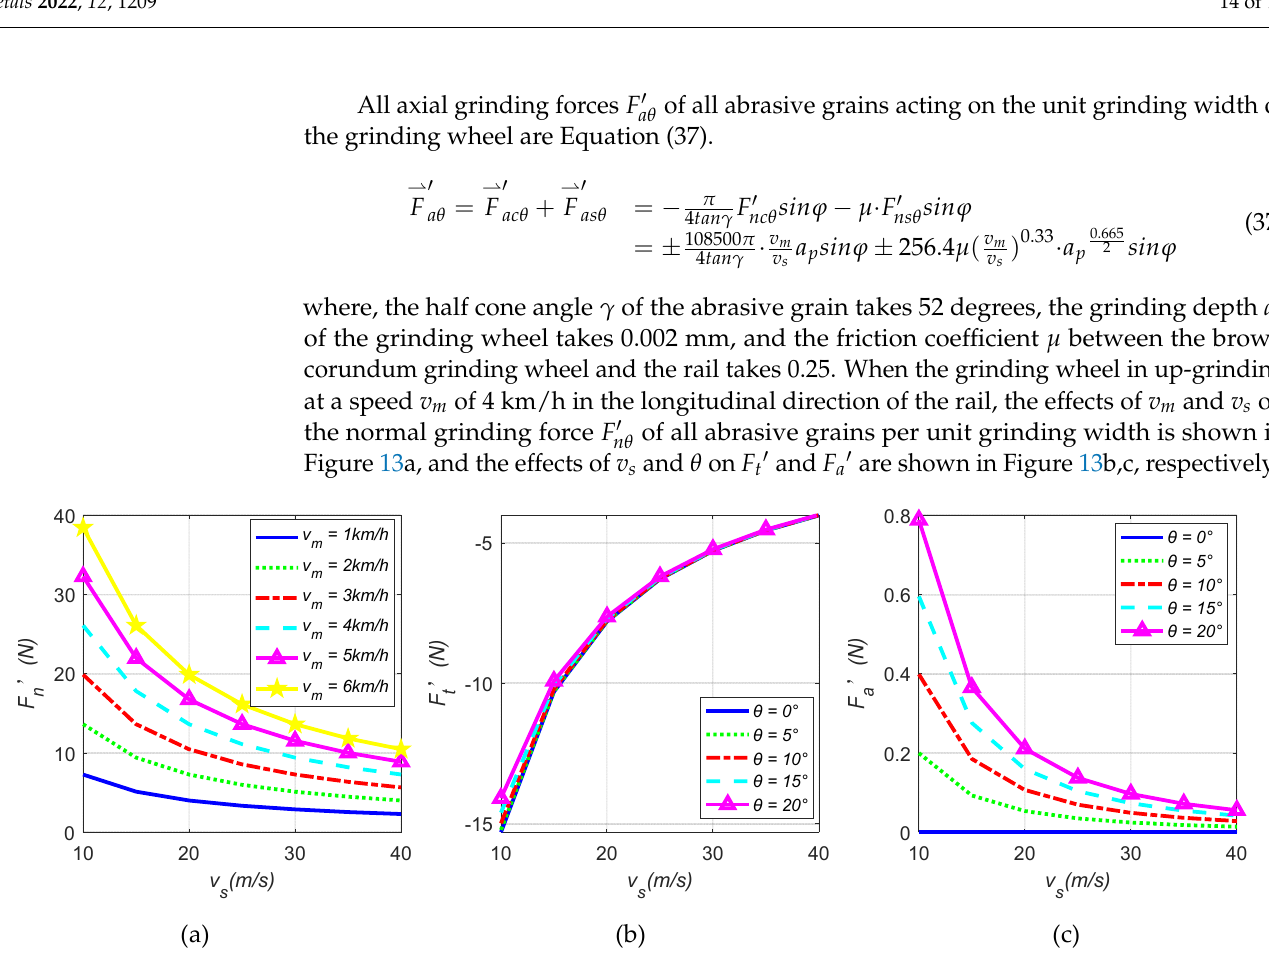
Figure 13. Effects of v m , v s , and θ on grinding force: ( a ) effects of v s and v m on F n ’; ( b ) effects of v s and θ on F t ’; ( c ) effects of v s and θ on F a ’.